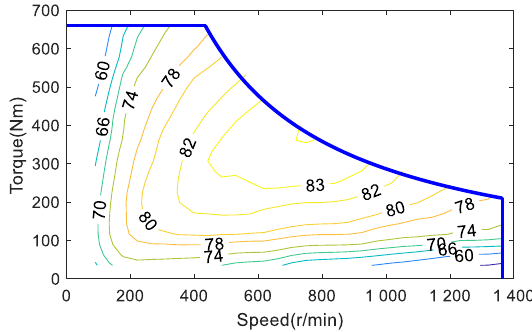
Figure 5. Motor efficiency map.